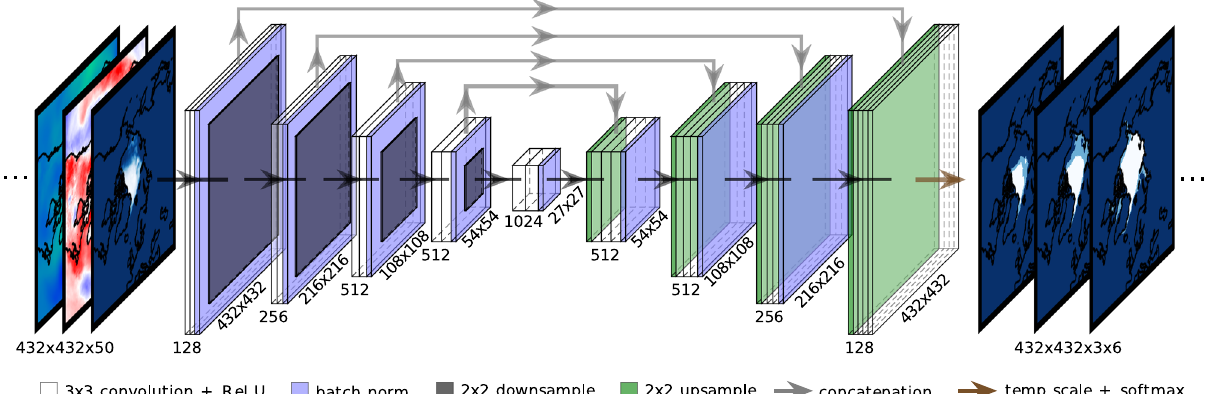
Fig. 1 The IceNet model. IceNet receives 50 monthly averaged climate variables as input (Supplementary Table 2), centred on the North Pole. IceNet, a deep learning U-Net model, receives these inputs and processes them through a series of convolutional blocks with batch normalisation (Supplementary Table 1). The number to the left of the convolutional blocks denotes the number of feature maps in each convolutional layer, while the number beneath denotes the feature map resolution. IceNet ’ s outputs are forecasts of three sea ice concentration (SIC) classes (SIC ≤ 15%, 15% < SIC < 80%, and SIC ≥ 80%) for the following 6 months in the form of discrete probability distributions at each grid cell. The latter two ice class probabilities are summed to obtain the sea ice probability, p = P (SIC >